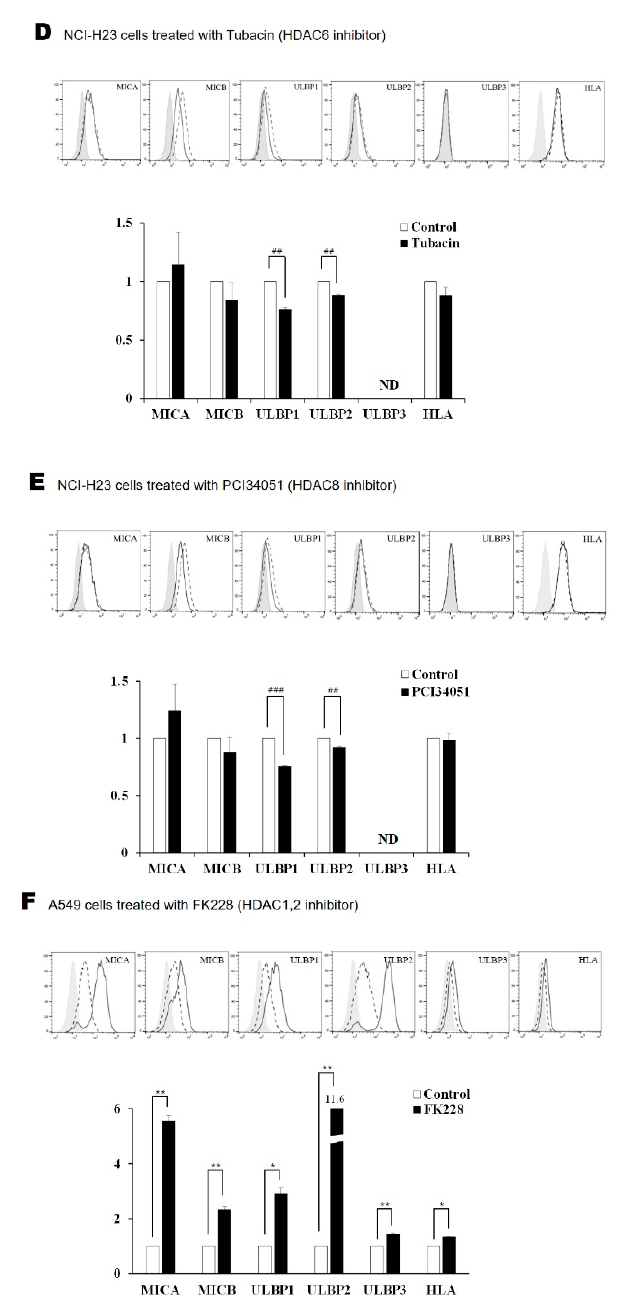
Figure 2. Treatment with HDAC inhibitors alters the surface expression of NKG2D ligands. Histograms show the surface expression of NKG2D ligands in NCI-H23 lung cancer cells that were treated for 24 h with 100 nM of ( A ) FK228, ( B ) RGFP966, ( C ) MC1568, ( D ) Tubacin, and ( E ) PCI34051. ( F ) The A549 cells were treated with 100 nM FK228 for 24 h. Relative expression ratios were calculated by comparing the MFI of FK228-treated cells with control cells. Solid gray, dotted, and black lines represent the isotype control, media-treated control, and HDAC inhibitor-treated samples, respectively. * represents a statistically significant increase and # represents a statistically significant decrease. p -values less than 0.05, 0.01, and 0.001 are marked as */#, **/##, and ***/### symbols, respectively. ND means not detected.